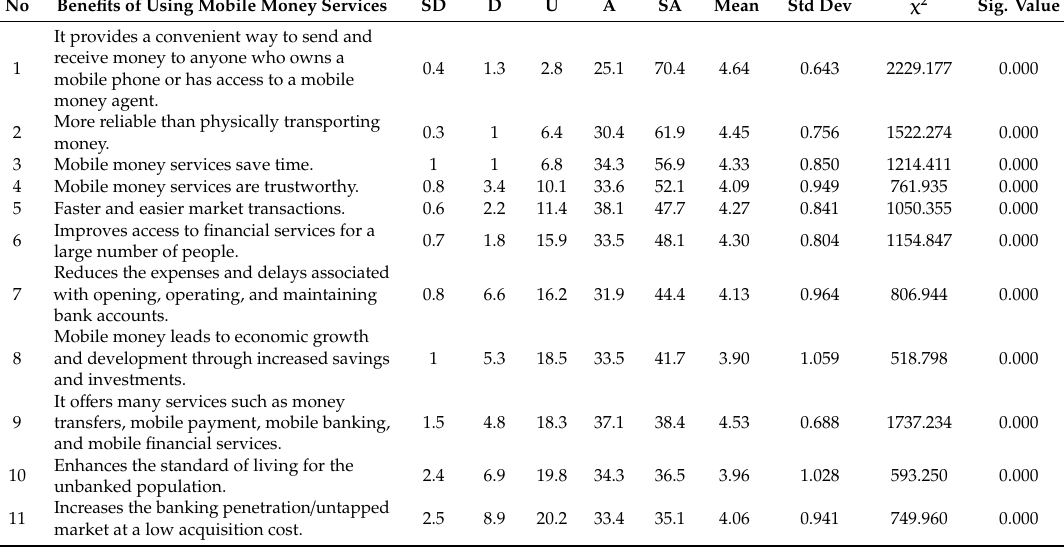
Table 3. Opinion of respondents regarding the benefits of using mobile money